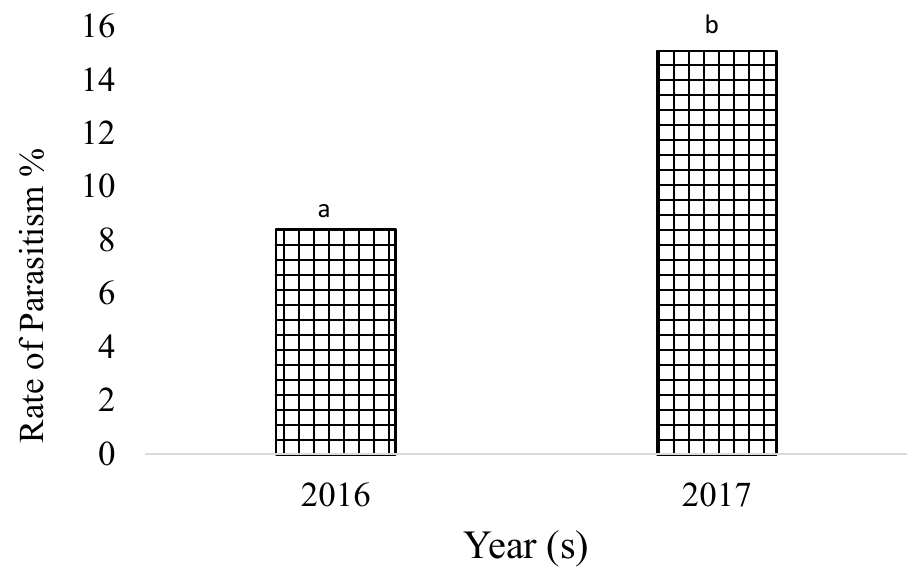
Figure 8. Total egg parasitism by P. saccharalis on M. cribraria in the three areas (urban, forest, and agricultural) compared by year. Different letters above the bar indicates significant difference between the years, Tukey’s Studentized Range, p < 0.05).